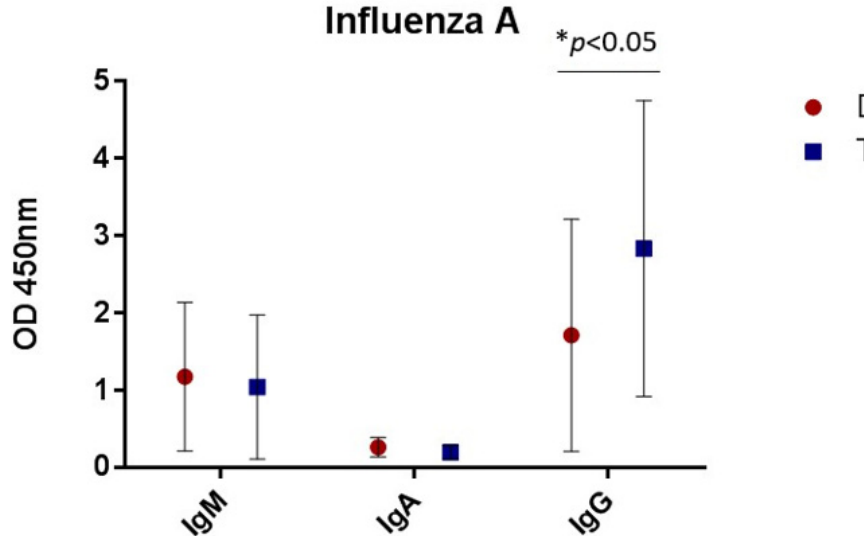
Figure 1. Using an ELISA to evaluate antibody concentration against influenza A virus. Results indicate that individuals with T21 have a significantly higher concentration of IgG antibodies to influenza A compared to typical, disomic individuals.